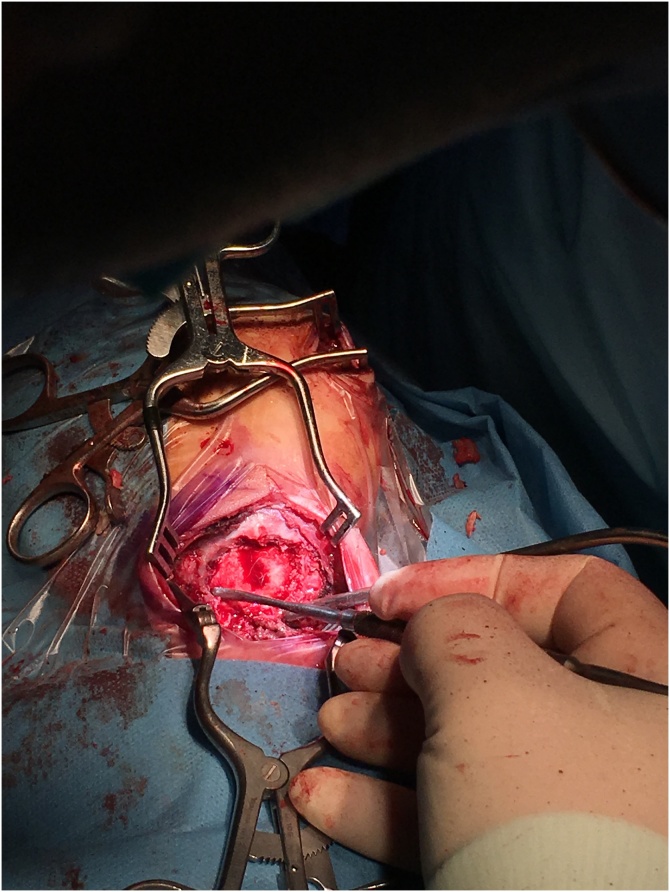
Intraoperative photograph, visualizing the small suboccipital craniectomy performed in order to identify the underlying cisterna magna.